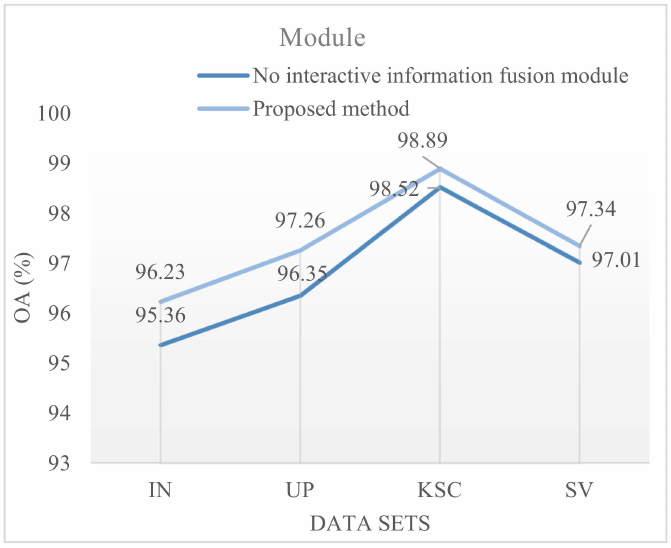
Figure 14. OAs with different feature extraction modules on IN, UP, KSC, and SV datasets